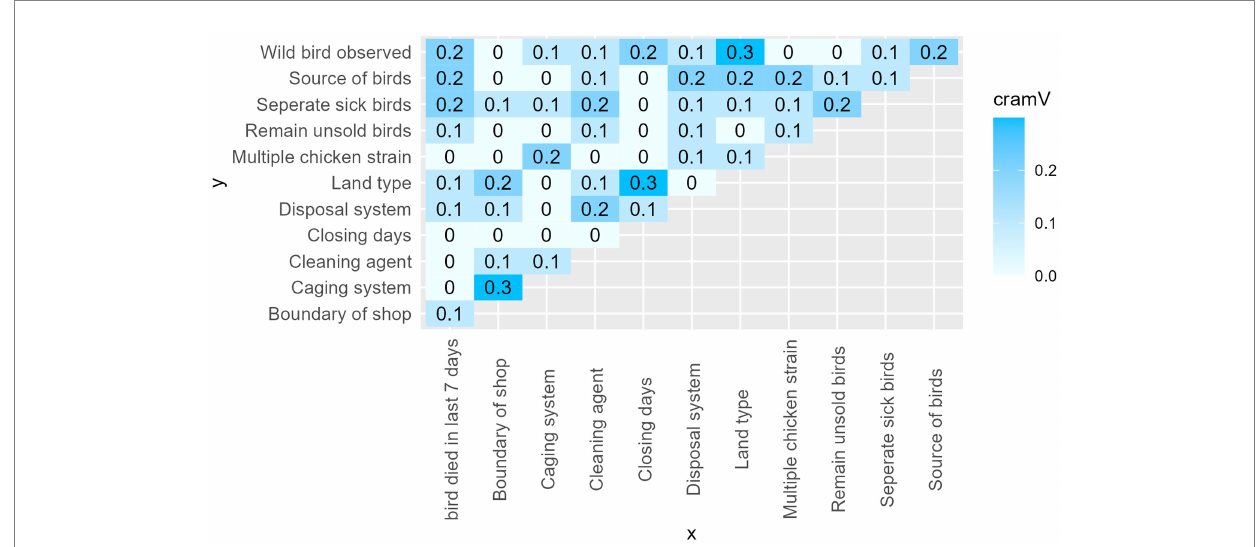
FIGURE 6 Cramer’s V values matrix between explanatory